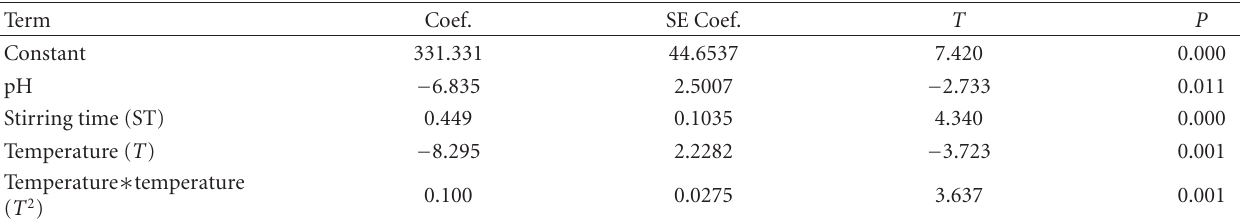
Table 9: Estimated regression coe ffi cients for concentration of leached copper (reduced).